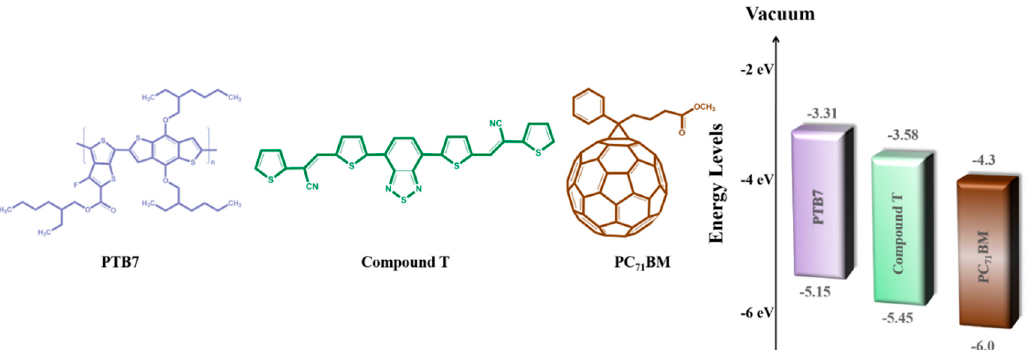
Figure 1. Chemical structures and energy levels of ternary blend’s component.